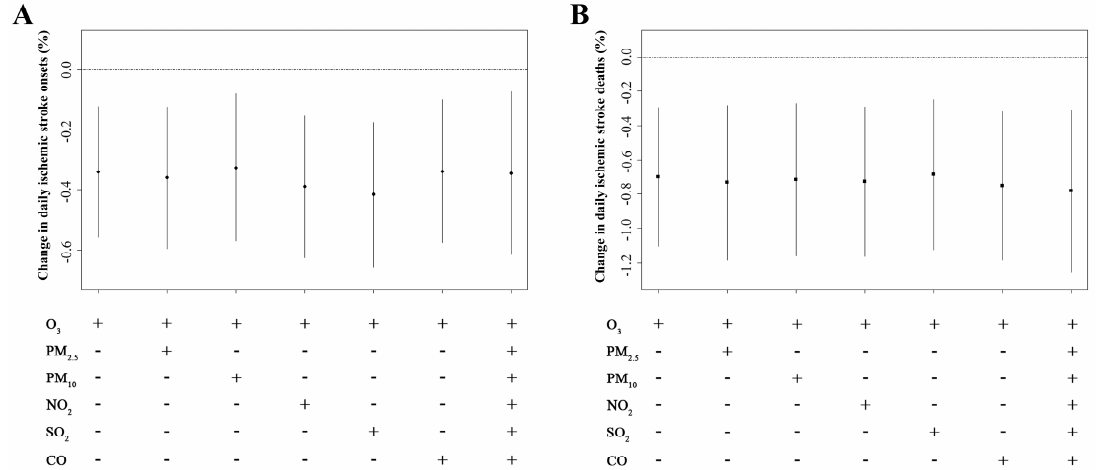
Figure 4. The percentage changes in daily ischemic stroke onsets ( A ) and deaths ( B ) with per interquartile range increment in O 3 concentrations at selected lag days (lag 0–5 for ischemic stroke onsets and lag 5 for daily ischemic stroke deaths) in two-pollutant and multi-pollutant models in Changzhou, 2015–2016. The data was expressed as mean with 95% confidence interval. O 3 indicates ozone; PM 2.5 , particulate matter that is ≤ 2.5 µ m in diameter; PM 10 , particulate matter that is ≤ 10 µ m in diameter; NO 2 , nitrogen dioxide; SO 2 , sulfur dioxide; CO, carbon monoxide.